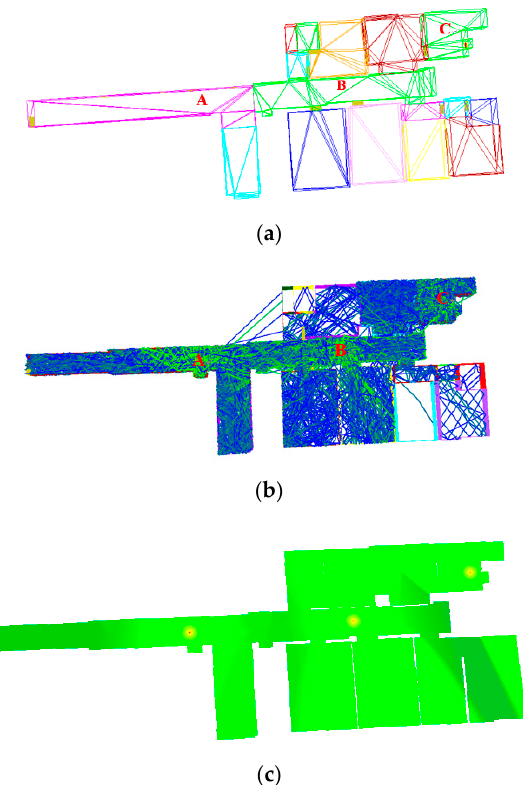
Figure 15. Signal intensity simulation. ( a ) Setting three base stations. ( b ) Multipath signal propagation. ( c ) Horizontal profile of signal intensity.